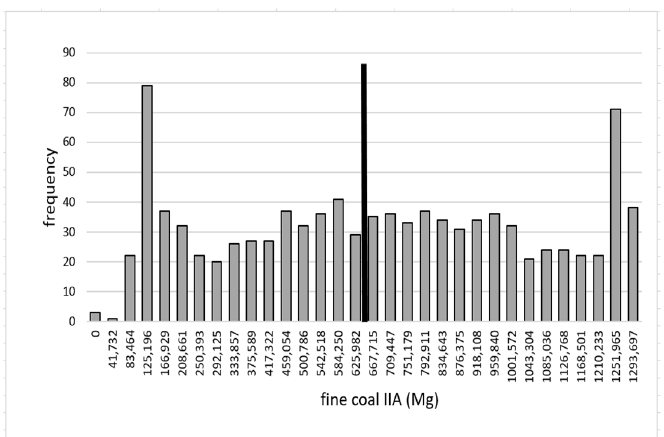
Figure A9. Histogram showing frequencies of achieving given quantity of sales of fine coal IIA (“Indv. Consumers 2”) for mine “D” with σ yprog .